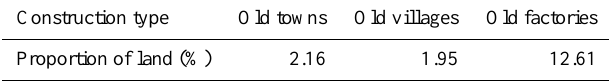
Table 2. The proportion of land according to construction type. Construction type